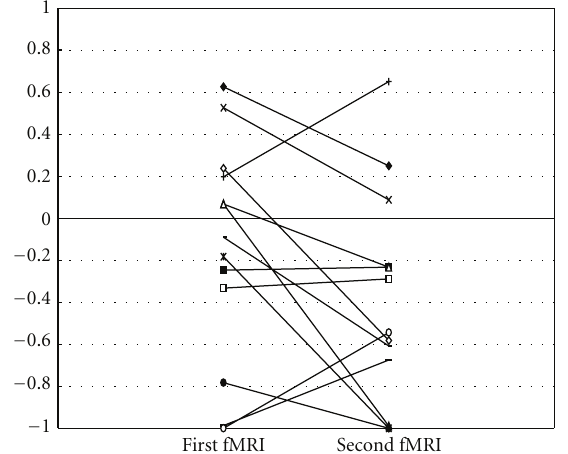
Figure 2: A comparison of AI between the first fMRI and the second fMRI of patients with